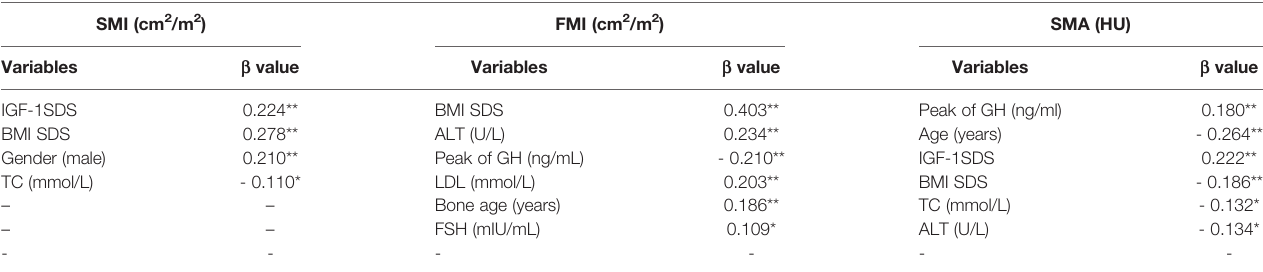
TABLE 3 | Multiple stepwise linear regression analysis of factors associated with SMI, FMI and SMA. SMI (cm 2 /m 2